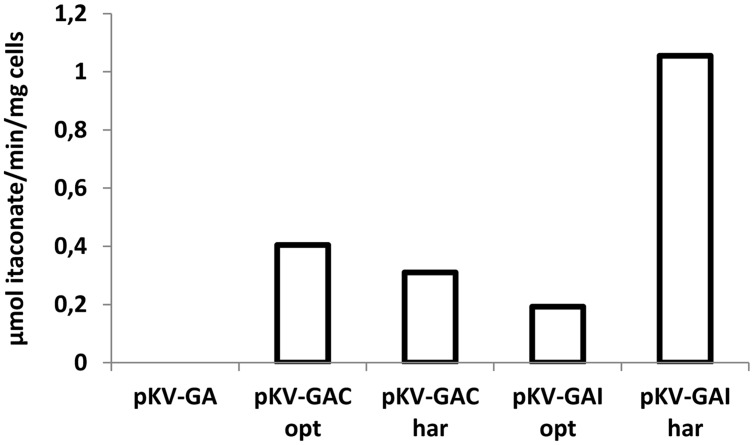
Conversion of cis-aconitate to itaconate (μmol itaconate/min/mg cells) by whole cells of E. coli BW25113 (DE3) Δpta–ΔldhA containing pKV-GA, pKV-GACopt, pKV-GAChar, pKV-GAIopt, and pKV-GAIhar. The average values of duplicate measurements are given.